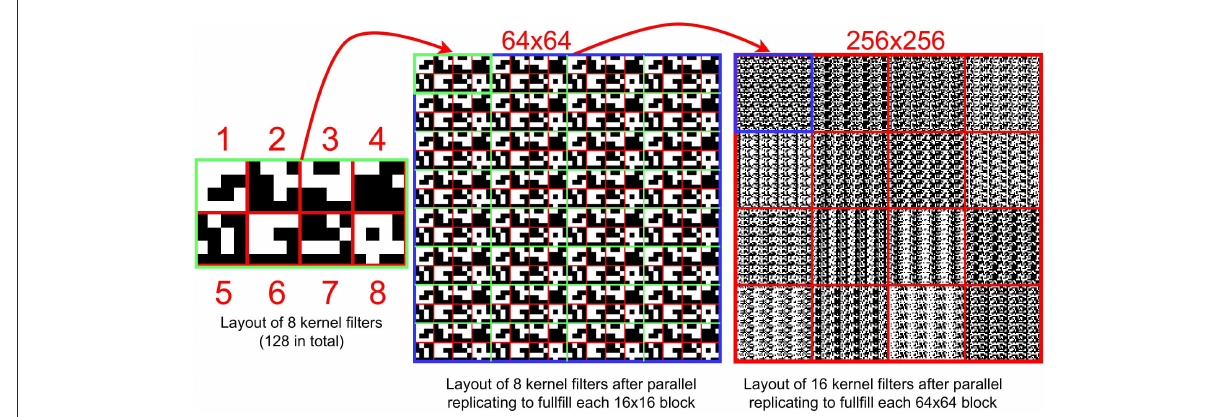
FIGURE8 (Left) The layout of 8 filters in a block with a size 16 × 8. (Middle) The layout of 8 kernel filters in a 64 × 64 block. (Right) The layout of 128 kernel filters. Before performing a convolution operation (8 times in total) in the 2nd layer, each set (8 sets in total) of kernel filters is activated and then replicated to fill all 256 × 256 PEs. With this method, 128 filters can be stored within one DREG.